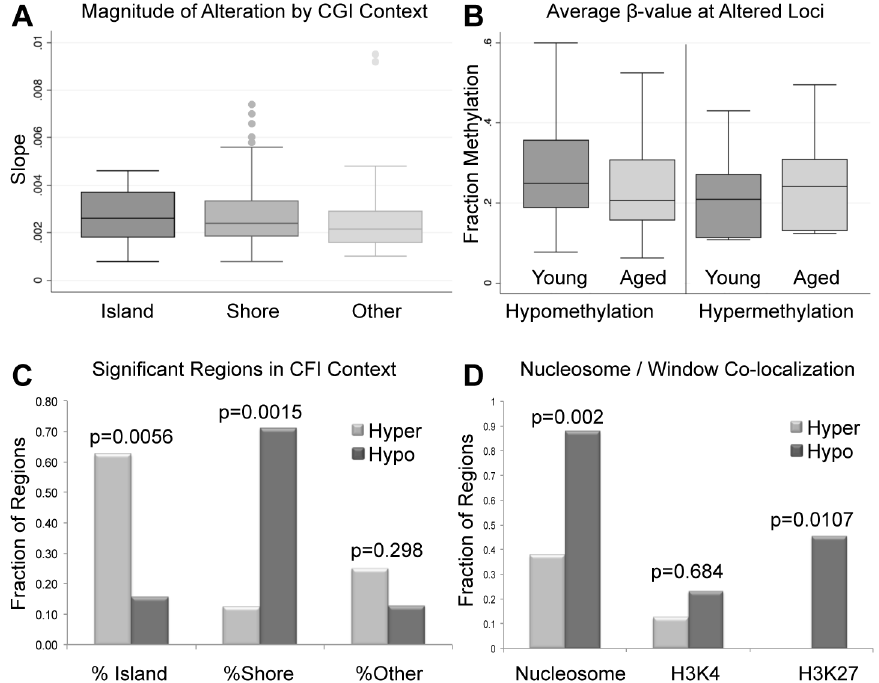
Figure 2. (A) The magnitude of alterations in terms of amount of change per year (reported as slope magnitude) for all regional changes that occur at CpG islands, shores and outside of these regions (other). Average alterations per year were approximately 0.281%. (B) Average b -values for all significant windows (hypomethylation and hypermethylation events) for both aged and young. Average decrease in b - value was approximately 3.9% for intra-individual hypomethylation events and 3.2% for hypermethylation events. (C) the percent of regions of hypermethylation and hypomethylation at CpG islands, shores and outside of these regions (Other). Hypermethylation events were significantly more enriched at islands than were hypomethylation events based on a fisher exact test (p=0.0056). Hypomethylation events were significantly more enriched at shores in comparison to hypermethylation events (p=0.0015). Hypermethylation and hypomethylation events were similarly enriched in regions outside of islands and shores. (D) We also investigated the co-localization of nucleosomes (every region of known histone retention) as well as histone modifications (H3K4 methylation, and H3K27 methylation) with our windows of interest. Hypermethylation events were less frequently associated with all retained histones (nucleosomes) or loci with H3K27 methylation when compared to hypomethylation events based on Fisher’s Exact Test (p=0.002; p=0.0107). Co-localization of hypermethylation or hypomethylation events with H3K4 methylation was statistically similar.